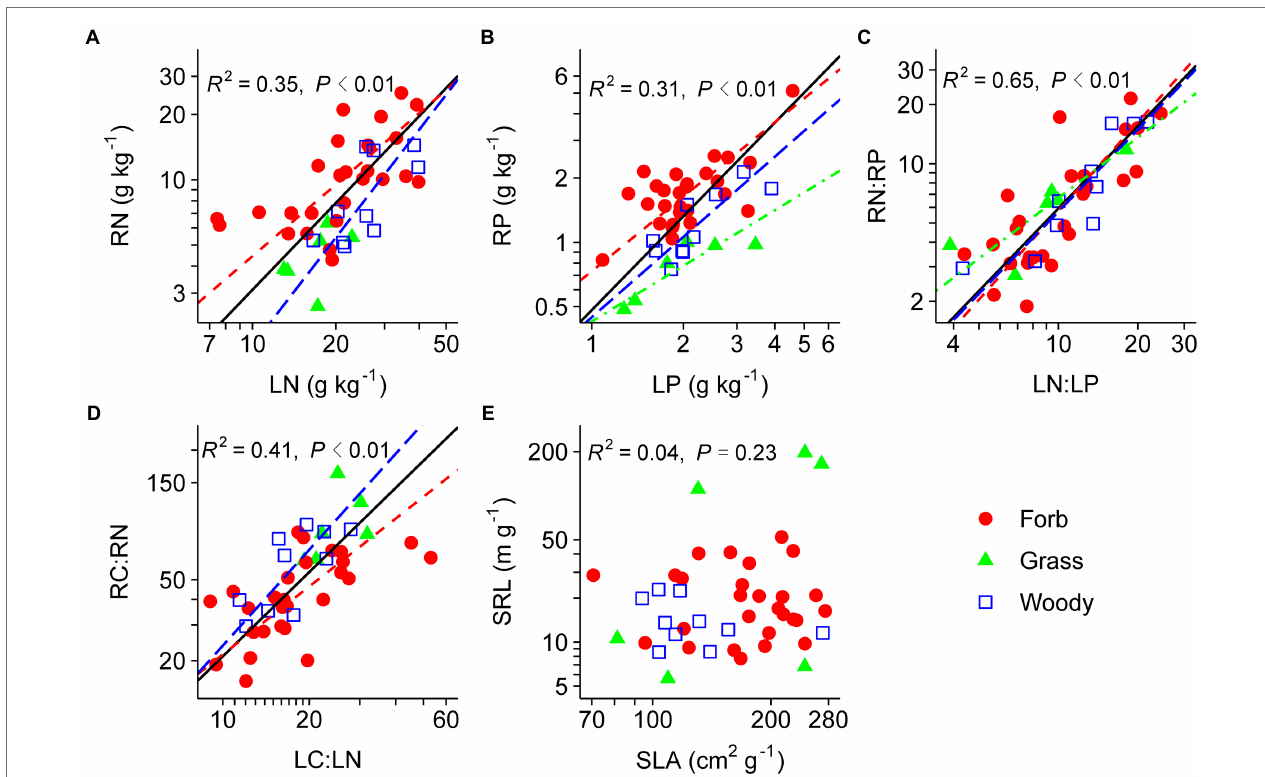
FIGURE 3 | Relationships between analogous leaf and fine-root traits across species, including the RN–LN relationship (A) , the RP–LP relationship (B) , the RN:RP– LN:LP relationship (C) , the RC:RN–LC:LN relationship (D) , and the SRL–SLA relationship (E) . For abbreviations see Figures 1, 2 . Species means are shown for forbs (closed circle), grasses (triangle), and woody species (open square). Solid lines ( R 2 and p values) represent linear fits across all species, red dashed lines represent linear fits for forbs, blue long-dashed lines represent linear fits for woody species, and green dot-dashed lines represent linear fits for grasses. Type II model was used for all linear fits. The log 10 scale was used on both x - and y -axis.